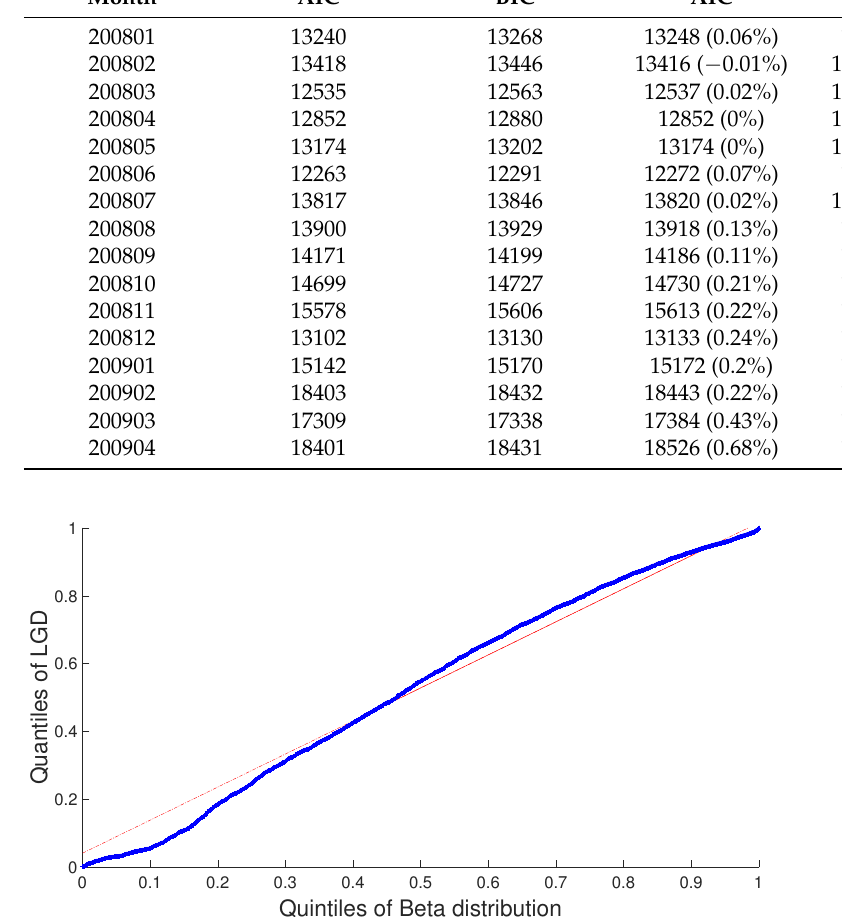
Figure 8. QQ-plot of February 2008 LGD data against fitted beta